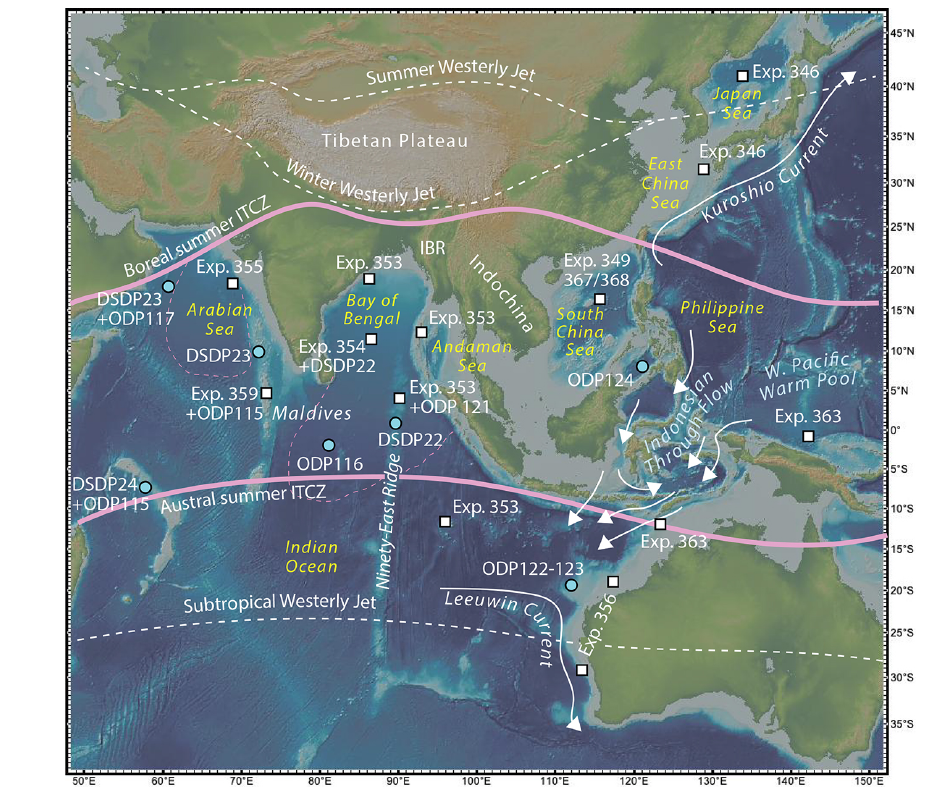
Figure 1. Shaded bathymetric map of the regions affected by the Asian and Australian monsoon systems showing the area of operations of the expeditions completed by IODP in the most recent campaign. Areas of older ODP and DSDP drilling are shown as blue dots. IBR is the Indo-Burman Range. Route of IFT after Gordon (2005). Dashed pink lines show outline of Indus and Bengal fans. ITCZ locations are from Yan (2005). Base map is from